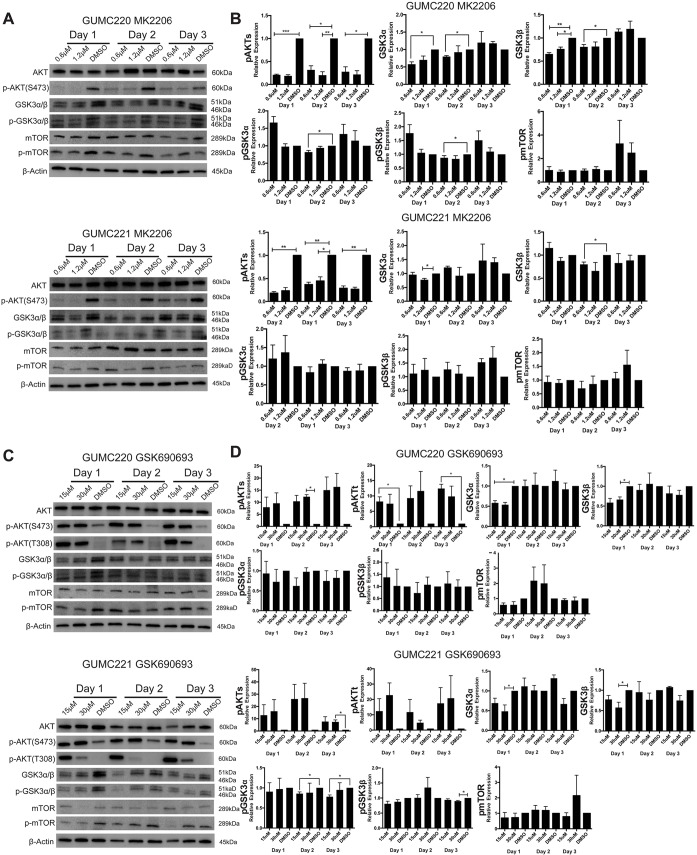
Western blot analyses of steady-state levels of AKT, P-AKT, GSK3α/β, p-GSK3α/β, mTOR and p-mTOR following exposure to MK2206 and GSK690693 in 2D culture (CM+Y). (A) Representative western blots of AKT, p-AKT(S473), GSK3α/β, p-GSK3α/β, mTOR, p-mTOR and β-actin from GUMC220 and GUMC221 exposed to MK2206 (0.6 μM and 1.2 µM) compared with DMSO vehicle control. (B) Steady-state expression levels of pAKT(S473), GSK3α/β, p-GSK3α/β and p-mTOR in GUMC220 and GUMC221 cells after 1, 2 and 3 days’ exposure to the two different concentrations of MK2206 and DMSO. Data are mean±s.e.m., n=3/timepoint/concentration. (C) Representative western blots of AKT, p-AKT(S473), p-AKT(T308), GSK3α/β, p-GSK3α/β, mTOR, p-mTOR and β-actin from GUMC220 and GUMC221 in 2D CM+Y culture exposed to GSK690693 (15 μM and 30 µM) compared with DMSO vehicle control. (D) Steady-state expression levels of pAKT(S473), p-AKT(T308), GSK3α/β, p-GSK3α/β and p-mTOR in GUMC220 and GUMC221 cells after 1, 2 and 3 days’ exposure to the two different concentrations of GSK690693 compared with DMSO vehicle control. Phosphoprotein levels were normalized to total proteins, which were normalized to actin. *P≤0.05, **P≤0.01, ***P≤0.001, one tailed, unpaired t-test. Protein lysates were collected after 1, 2 and 3 days of drug exposure. Data are mean±s.e.m., n=3/timepoint/concentration. Molecular weights (kDa) are indicated for each protein.